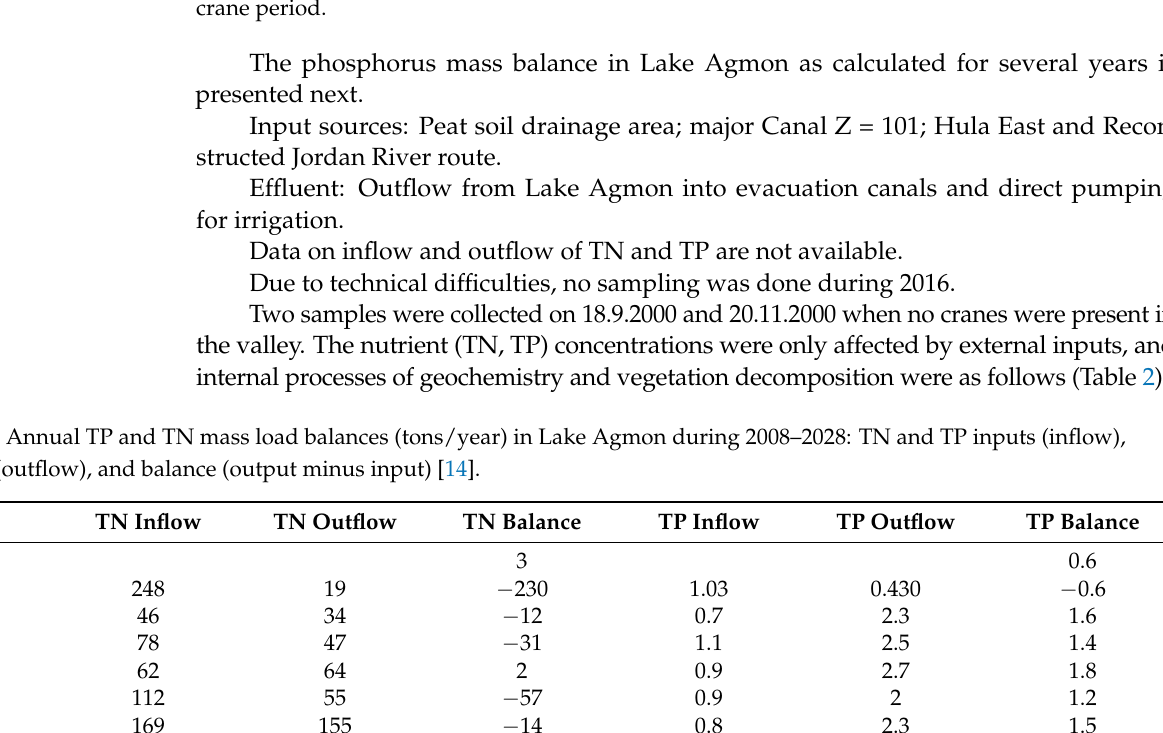
Figure 10. Temporal (1970–2018) changes in annual means of nutrient concentrations (mg/L; ppm) in River Jordan waters: Upper left : organic nitrogen. Upper right : total dissolved phosphorus. Lower left : total nitrogen. Lower right : total phosphorus. 1970–1993—no-crane period; 1994–2018— crane period.